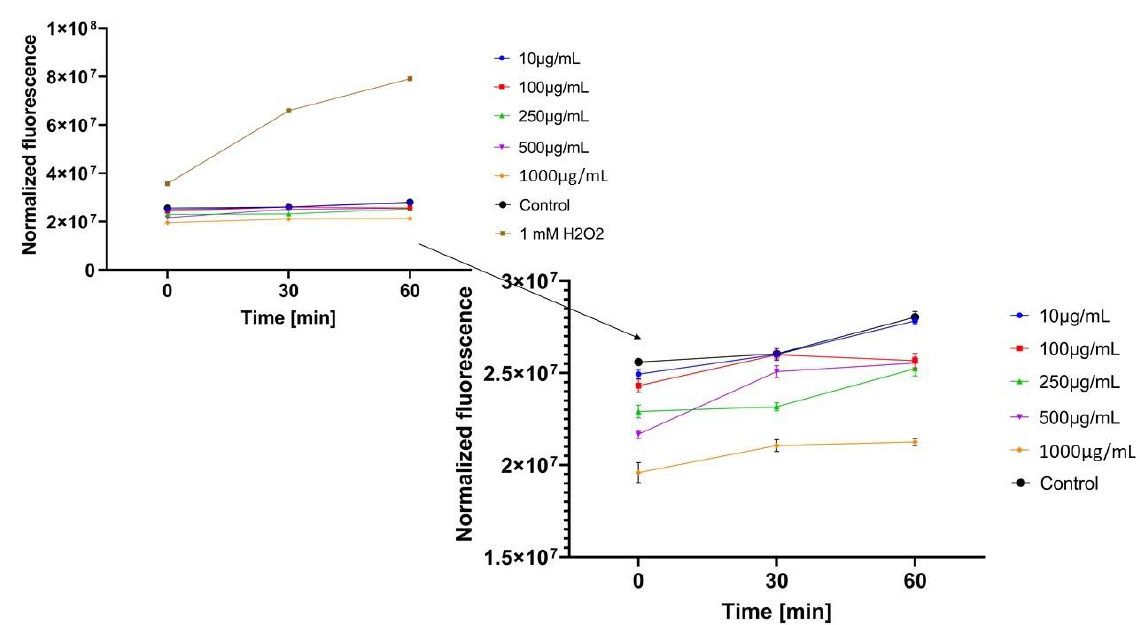
Figure 7. The effect of Centella asiatica L. extract on the 2’,7’-dichlorofluorescein (DCF) fluorescence in fibroblast cellsBJ. The data are expressed as the mean ± SD of 3 independent experiments, each of which consisted of 3 replicates per treatment group.